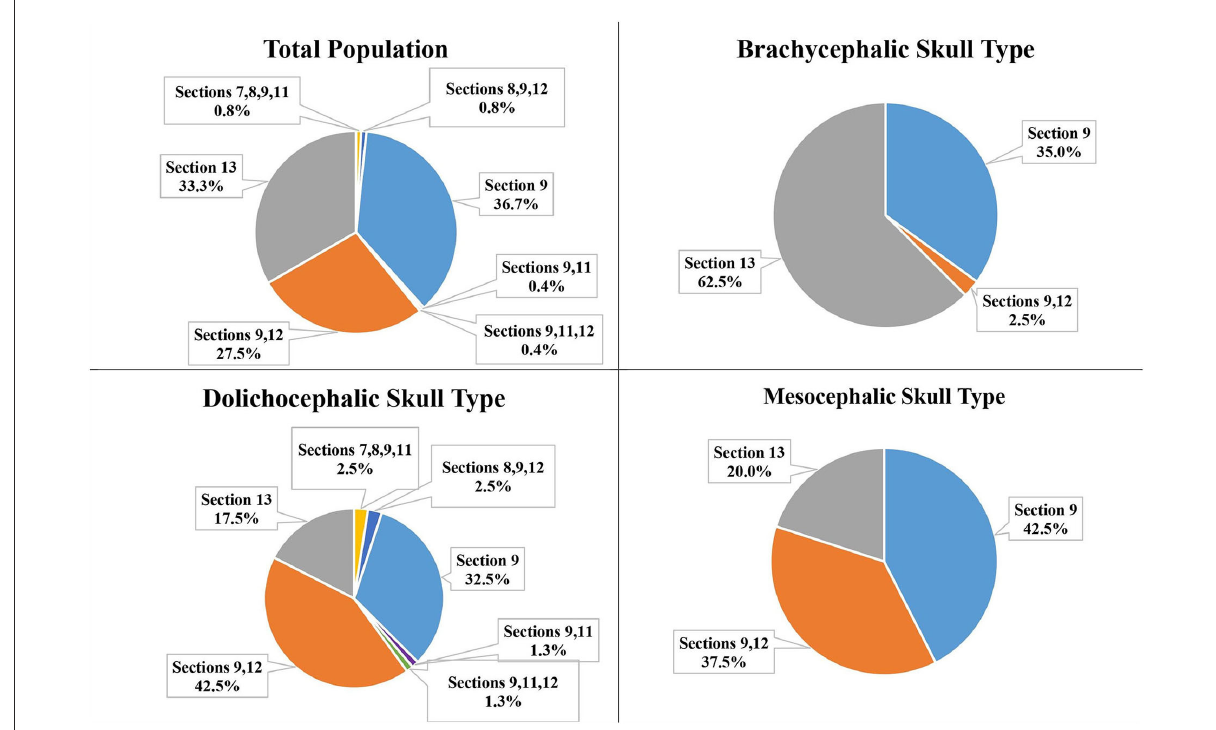
FIGURE7 Position of the IOC and Section 13 relative to the distal root of the P4 for the total population and the three different skull types.